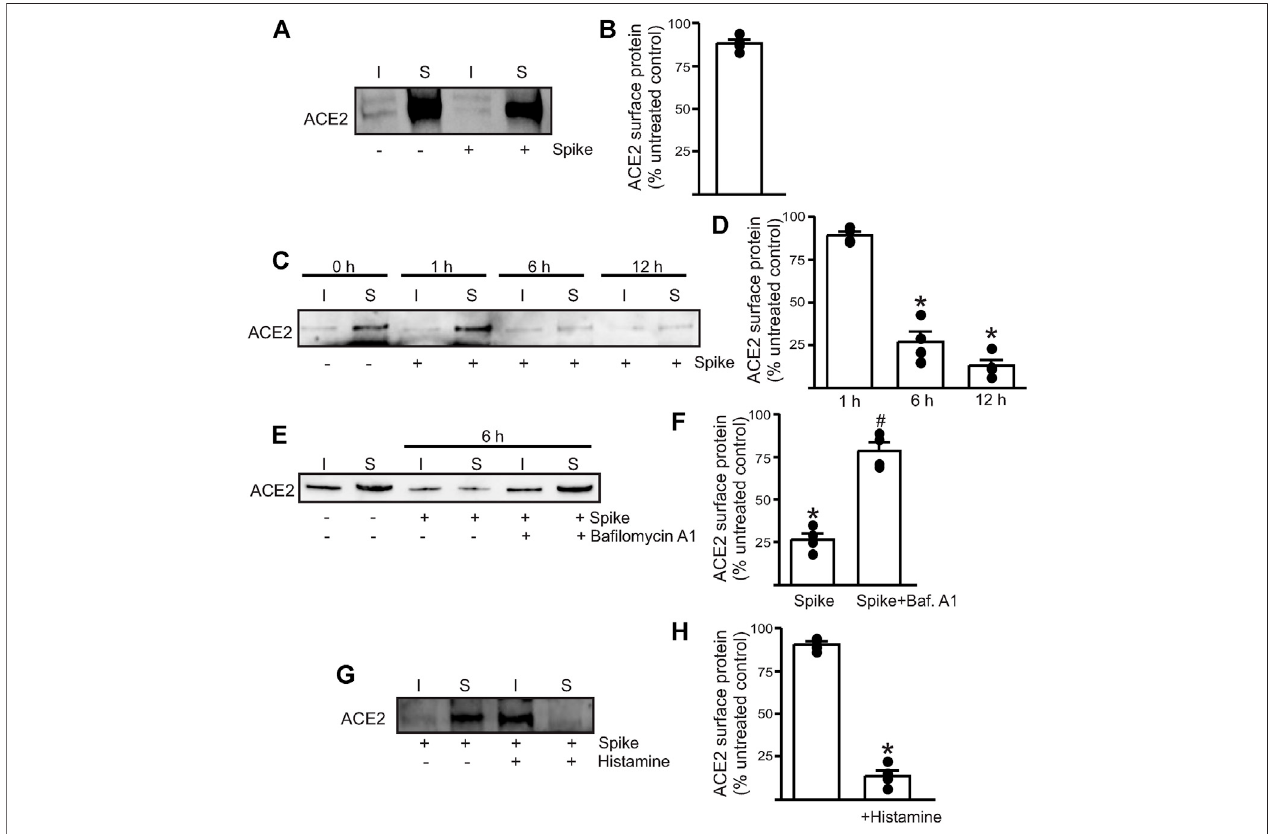
FIGURE 1 | Spike-induced ACE2 internalization is enhanced in the presence of histamine. (A) Representative Western blotting after surface biotinylation of intact endothelialcells withor without spike treatment for30 min. (B) Meandata. (C) Representative Western blot after surfacebiotinylationshowingthat increased incubation timeafterspiketreatmentinducedACE2internalizationanddegradation. (D) Meandata.* p < 0.05 vs .surfacebandintensityoftheuntreatedcontrol. (E) Representative Western blot after surface biotinylation showing the effect of ba fi lomycin A1 on spike-induced ACE2 degradation. (F) Mean data, * p < 0.05 vs . untreated, # p < 0.05 vs .spiketreated. (G) RepresentativeWesternblotaftersurfacebiotinylationshowingthathistaminepotentiatesspike-inducedACE2internalizationwithin30 minof treatment. (H) Meandata,* p < 0.05 vs .surfacebandintensityofuntreated control. n =4foralltheexperimental sets.I-indicatesintracellularfraction,S-denotes surface or plasma membrane